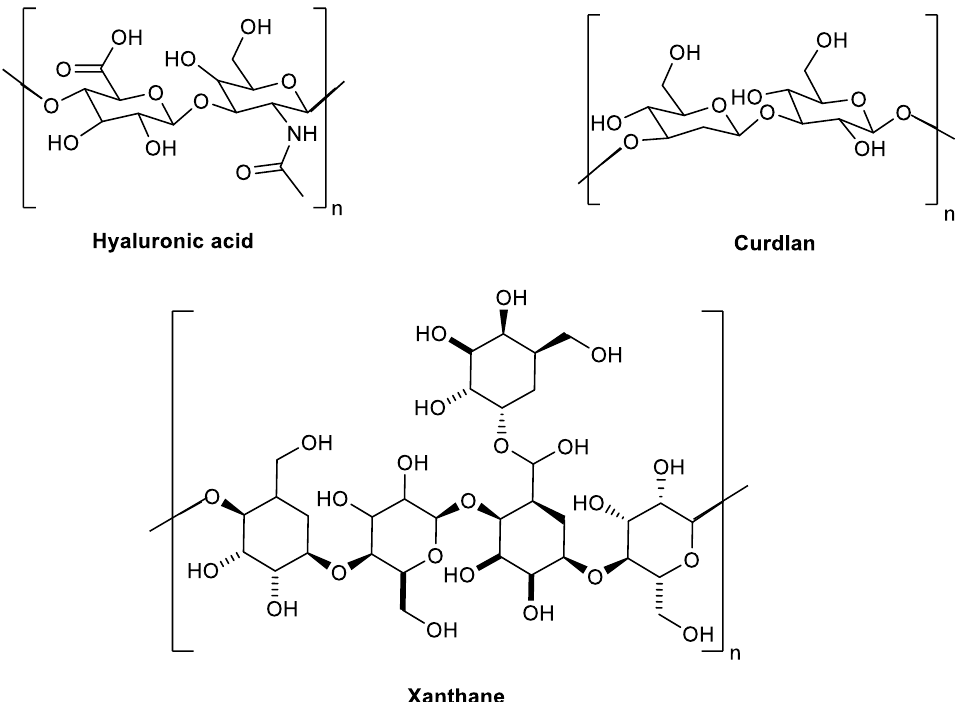
Figure 1. The chemical structure of selected bioactive microbial exopolysaccharides illustrating the diverse in the main chemical scaffold of microbial EPSs.